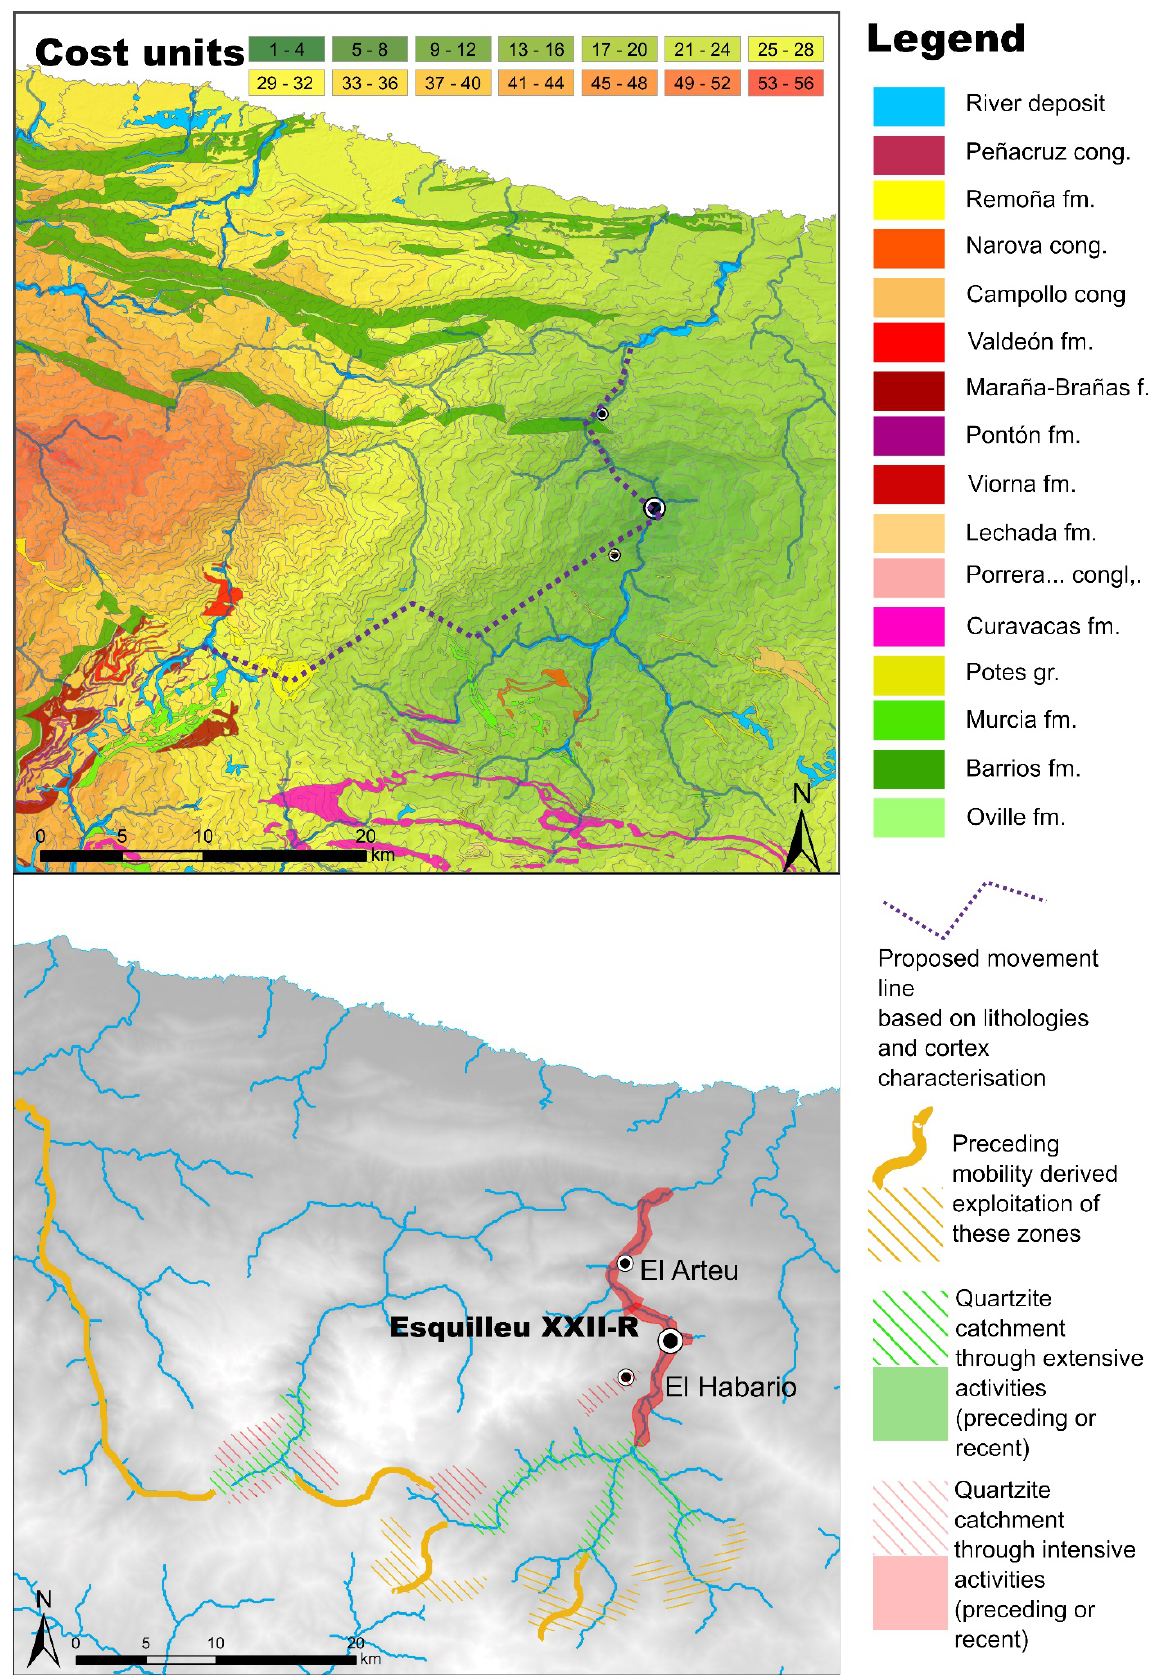
Figure 10. Cost map to strata where interesting quartzite could be acquired on the research area (on the left). Quartzite procurement areas map (on the